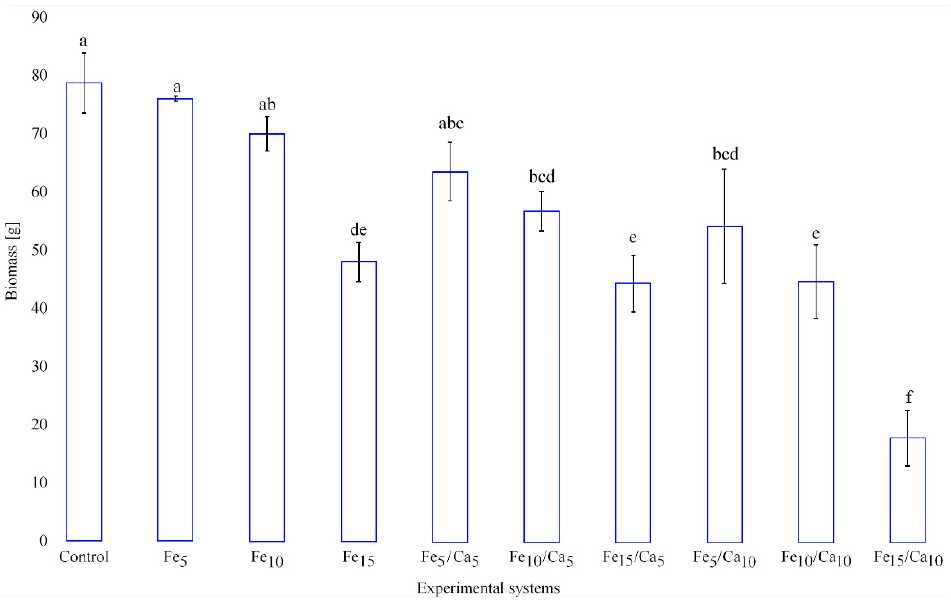
Figure 2. Yield (g) of Pholiota nameko exposed to particular experimental systems. n = 5, identical lower cases (a, b…) denote non-significant differences between mean Pholiota nameko yield growing in particular experimental systems according to post-hoc Tukey’s HSD test.